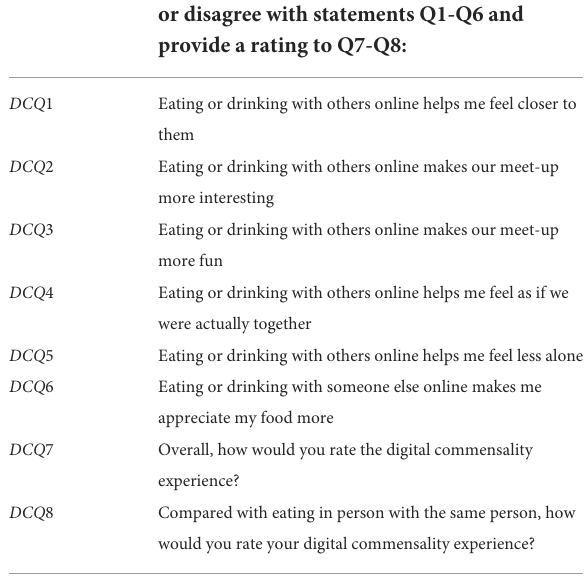
TABLE 3 Digital Commensality Questionnaire items and Digital Commensality experience ratings.